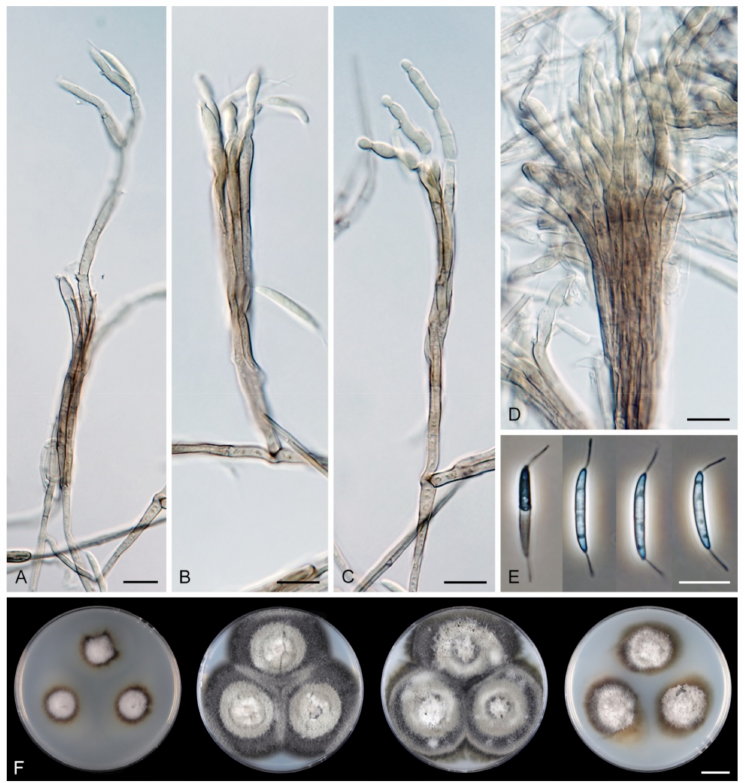
Figure 5. Arcuatospora sp 2. (MUCL 43189). ( A – D ) synnemata ( E ) conidia ( F ) colonies on CMD, MLA, OA and PCA after 4 weeks (from left to right). Images: ( A – E ) on PCA after 8 weeks. Scale bars: ( A – E ) 10 µ m; ( F ) 1